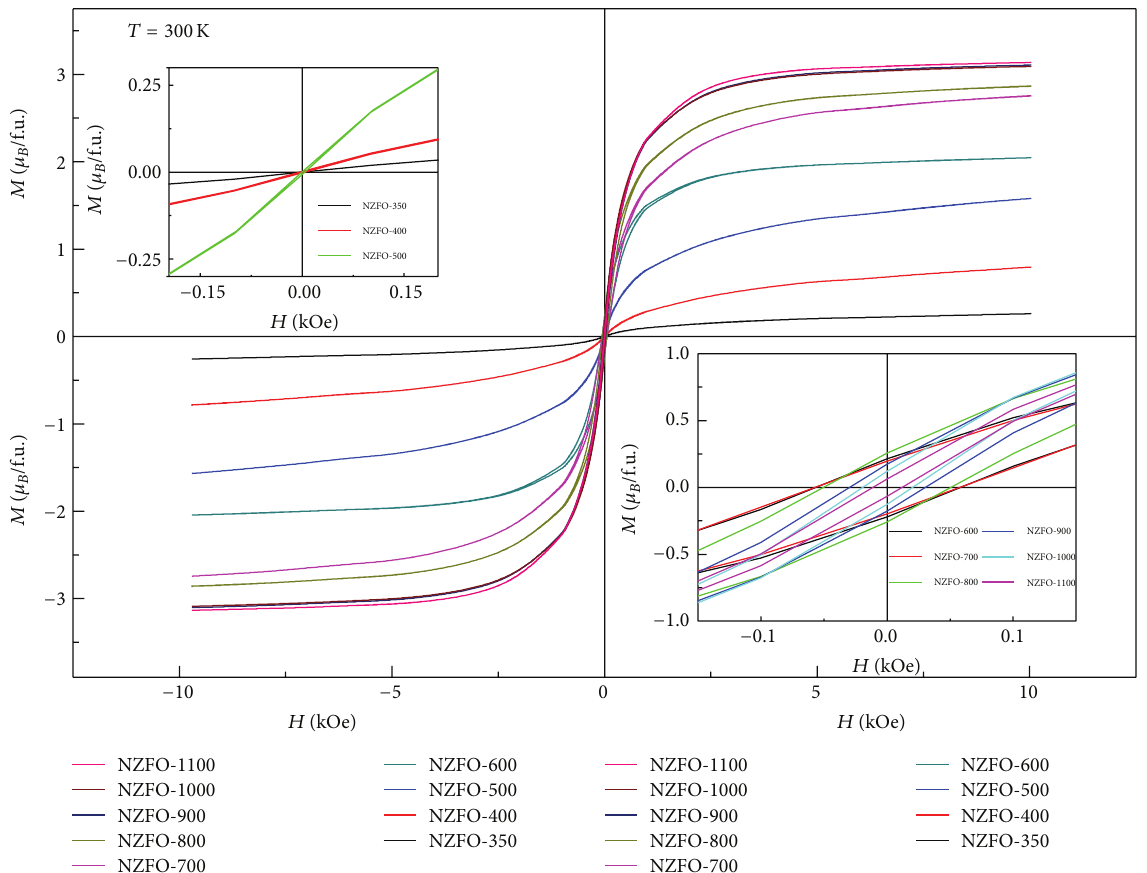
Figure 4: Room-temperature M-H loops for Ni-Zn ferrites with different particle sizes. The inset shows the magnified view of the M-H curves at lower applied field for a series of sample.